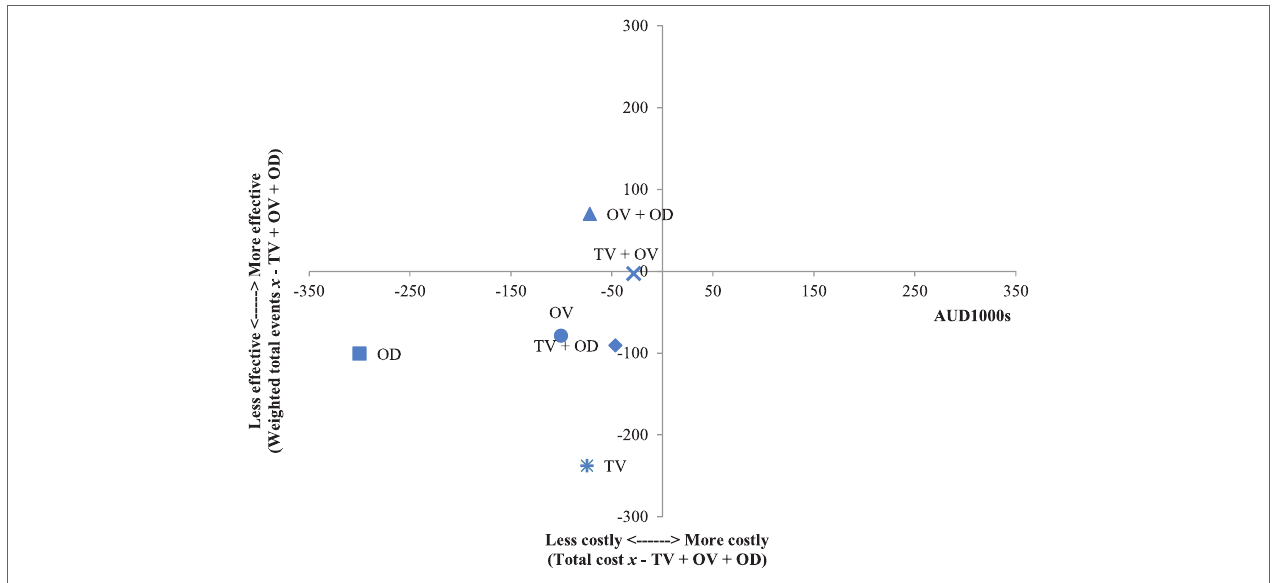
FiguRE 7 | Incremental cost-effectiveness of each format compared with television (TV) + online display (OD) + online video (OV). The cost-effectiveness of TV + OV + OD forms the baseline (cross-section of x and y axes). Effectiveness is weighted total events of each format ( x ) compared with TV + OV + OD. Cost is total costs in AUD1,000s of each format ( x ) compared with TV + OV + OD. Data points that fall in the upper left quadrant represent formats that are more cost-effective than TV + OV +